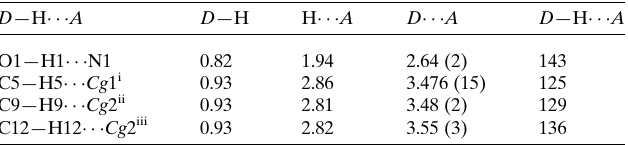
Table 1 Hydrogen-bond geometry (A˚ , (cid:2)